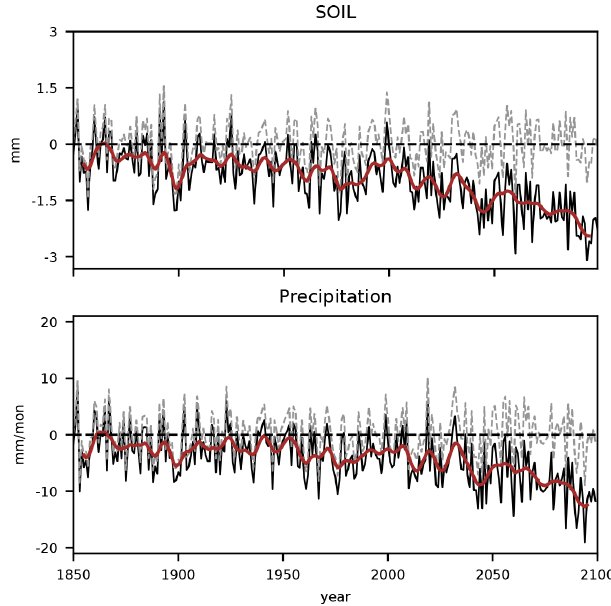
Figure 12. The same boxplot as Fig. 10 but for standardized re- gional atmospheric and soil variables over the region of study dur- ing Mediterranean droughts: anomalies of geopotential height at 850hPa (GP), surface temperature (TS), soil moisture (SOIL), sen- sible heat flux (SH), latent heat flux (LH), and evapotranspira- tion (EV). (b) Frequencies of occurrences of positive and negative anomalies in each stage of droughts in order: initiation, transition, and termination years.